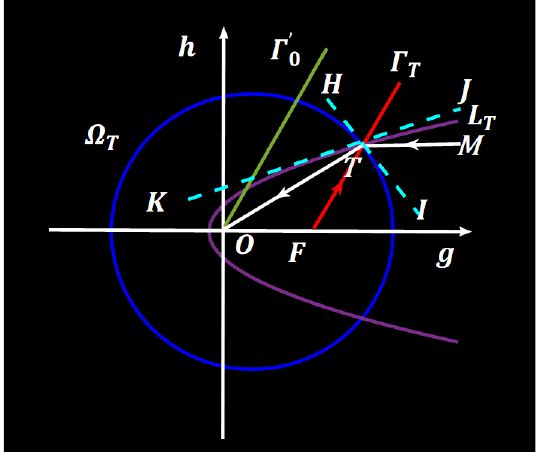
Figure A2. Geometrical analysis on T -plane based on geometry of light beam reflection onto the parabola and